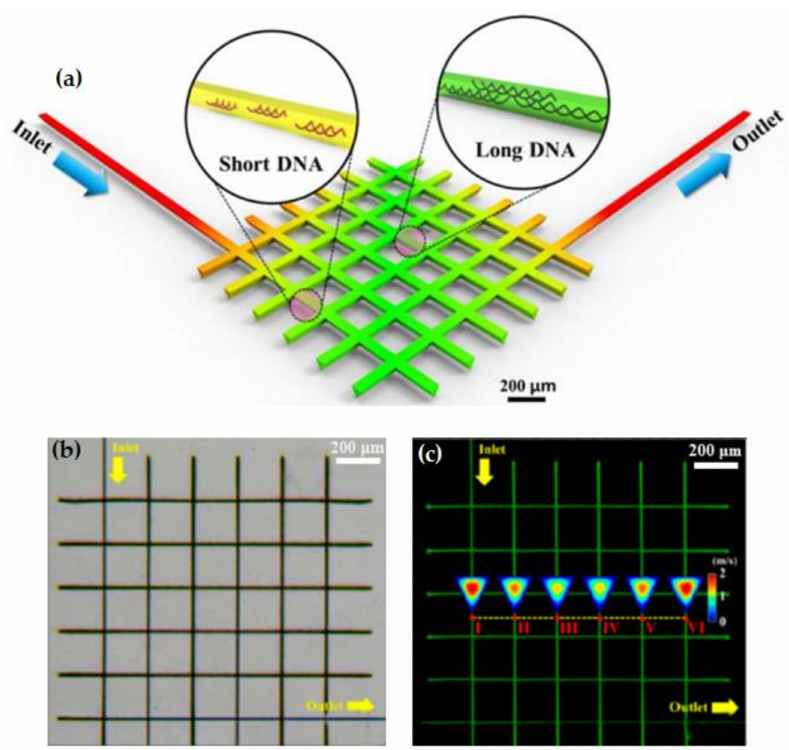
Figure 20. ( a ) Schematics of the DNA distributor; ( b ) tThe SEM image of the manufactured DNA distributor; and ( c ) fluorescence image of DNA solution distribution in each channel at a flow rate of 5 µ L/min [92].